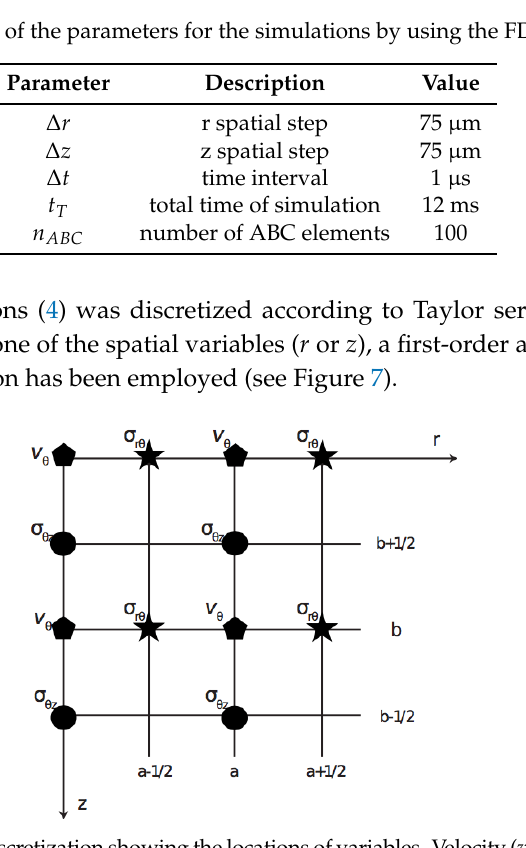
Figure 7. Staggered grid discretization showing the locations of variables. Velocity ( v θ ) and stresses ( σ r θ , σ θ z